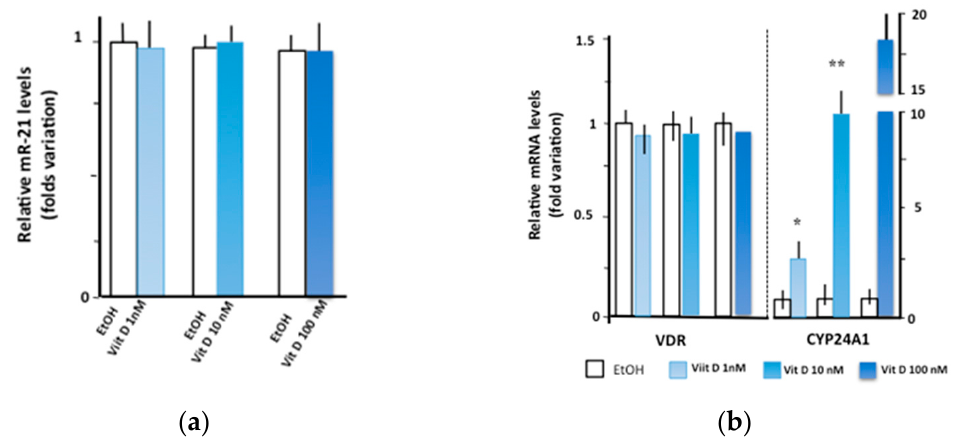
Figure 2. In vitro effects of 1,25(OH) 2 D 3 treatment on miR-21, vitamin D receptor messenger RNA, and cytochrome P450 family 24 subfamily A member 1 messenger RNA expression levels. Human embryonic kidney (HEK293) cell lines were treated with different concentrations (1 nM, 10 nM, and 100 nM) of 1,25(OH) 2 D 3 for 24 h. ( a ) Real-time quantitative polymerase chain reaction (RT-qPCR) analyses of miR-21 in HEK293 cells treated with 1,25(OH) 2 D 3 . The relative levels of miR-21 were evaluated using as control cells treated with ethanol vehicle control (EtOH) alone. MiR-16 was used as an internal standard for normalization. ( b ) Single gene expression analysis in HEK 293 cells treated with 1,25(OH) 2 D 3 . The relative amounts of vitamin D receptor (VDR) and cytochrome P450 family 24 subfamily A member 1 (CYP24A1) messenger ribonucleic acid (mRNAs) after 1,25(OH) 2 D 3 treatments were evaluated with RT-qPCR using as control EtOH–treated cells. Statistical differences of Δ Ct were marked with * standing for p < 0.05 and ** standing for p < 0.01.